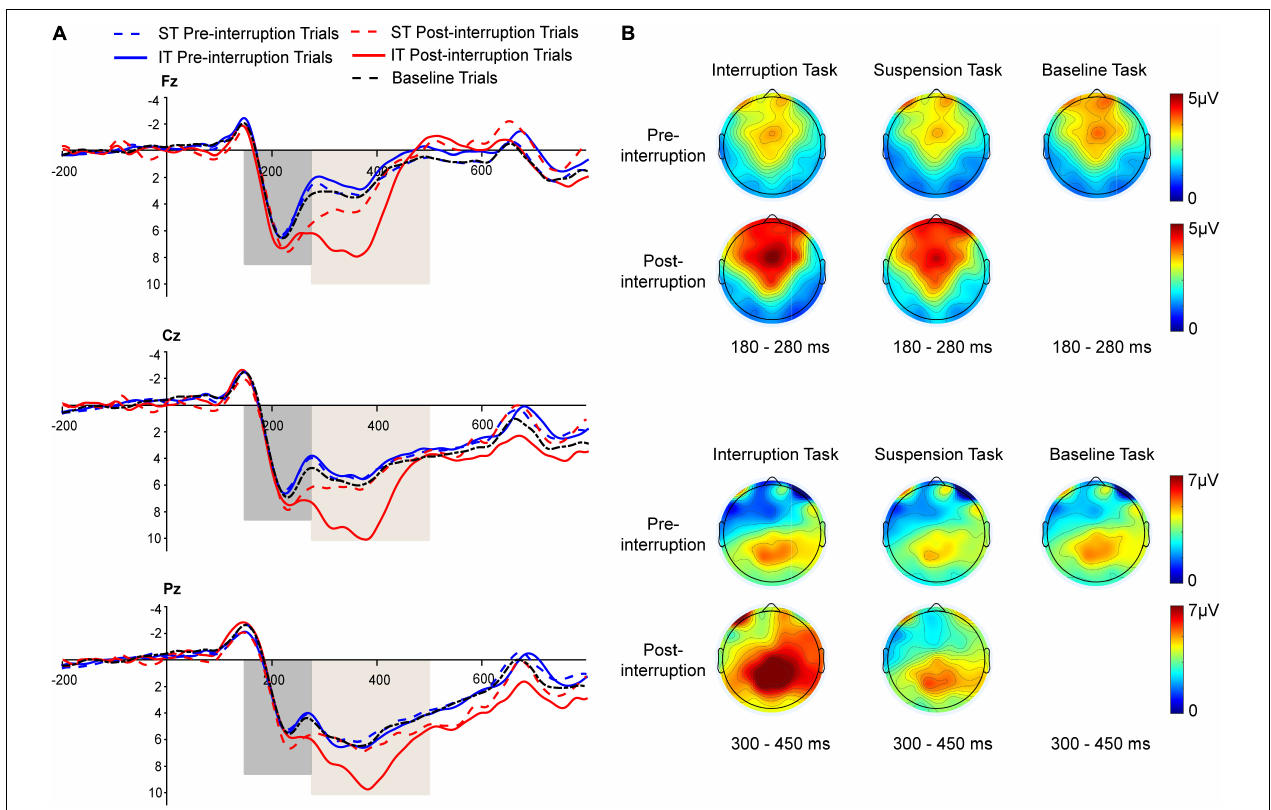
FIGURE 6 | (A) Grand averages of P200 and P300 ERP components at the Fz, Cz, and Pz electrodes under fatigue state. The black dashed line represents all trials of the baseline task. The blue and red dashed lines represent the pre- and post-interruption trials of the suspension task (ST). The blue and red solid lines represent the pre- and post-interruption trials of the interruption task (IT). (B) The scalp topographies display the mean amplitude under fatigue state of 180–280 ms for P200 and 300–450 ms for P300.